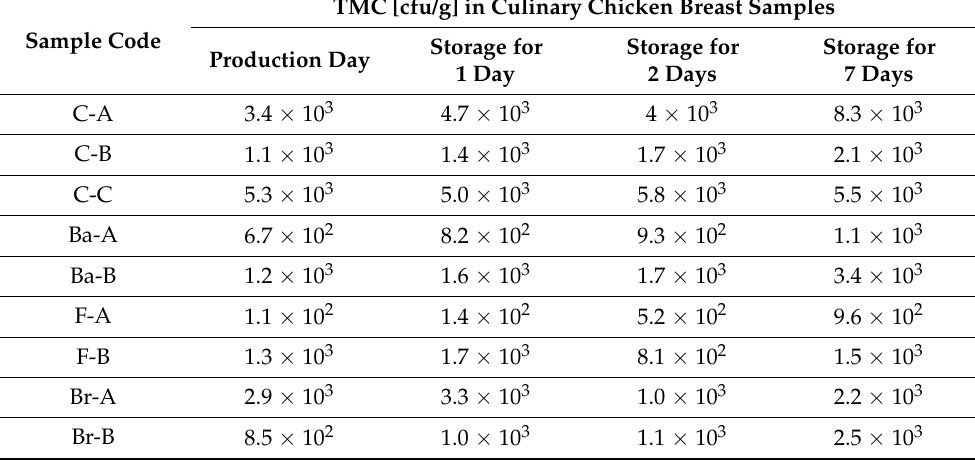
Table 11. Total microbial count [TMC] in culinary chicken breast